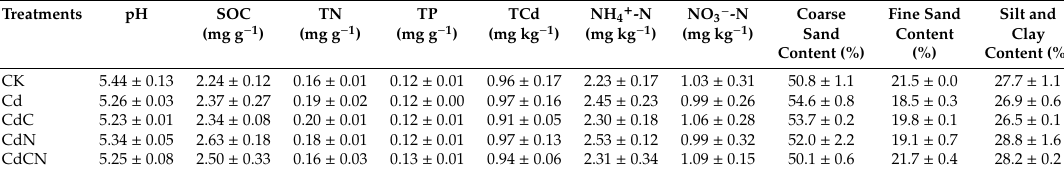
Table 1. Soil physicochemical properties of the surface 10 cm soil layers before treatments. SOC, soil organic carbon; TN, total nitrogen content of soil; TP, total phosphorus content of soil; TCd, total cadmium content of soil; NH 4 + -N, ammonium-N content of soil; NO 3— N, nitrate content of